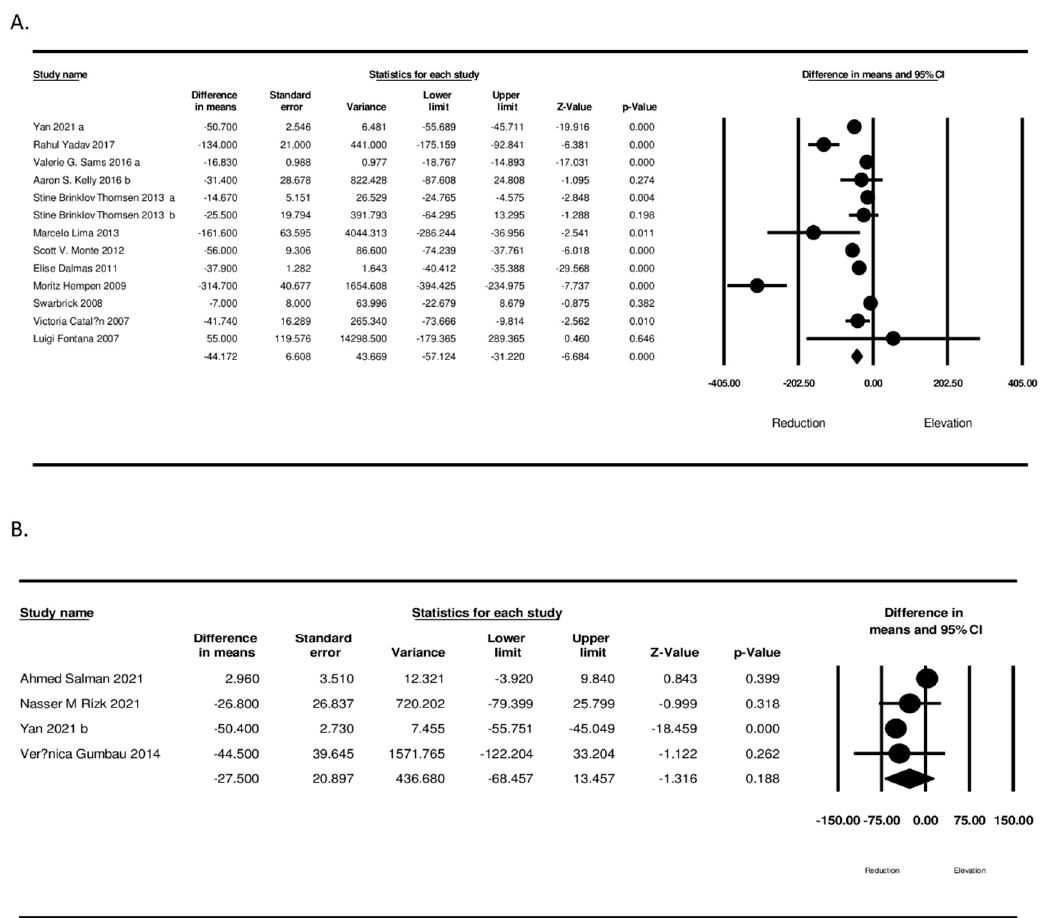
Figure 5. Subgroup analysis based on type of surgery (( A ) RYGB) (( B ) LSG).